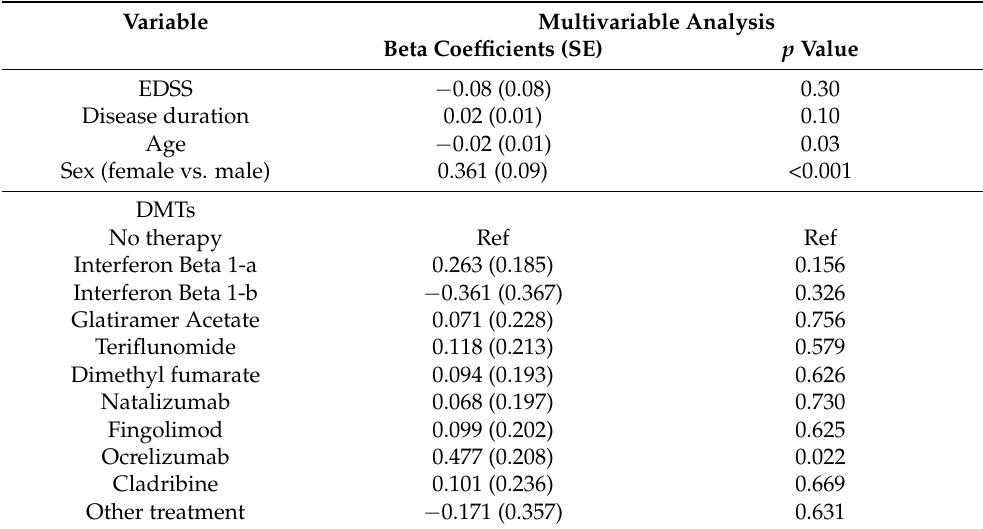
Table 3. Multivariable analysis assessing factors associated with Adverse Events Following Immu- nization (AEFIs). Variable Multivariable Analysis Beta Coefficients (SE) p